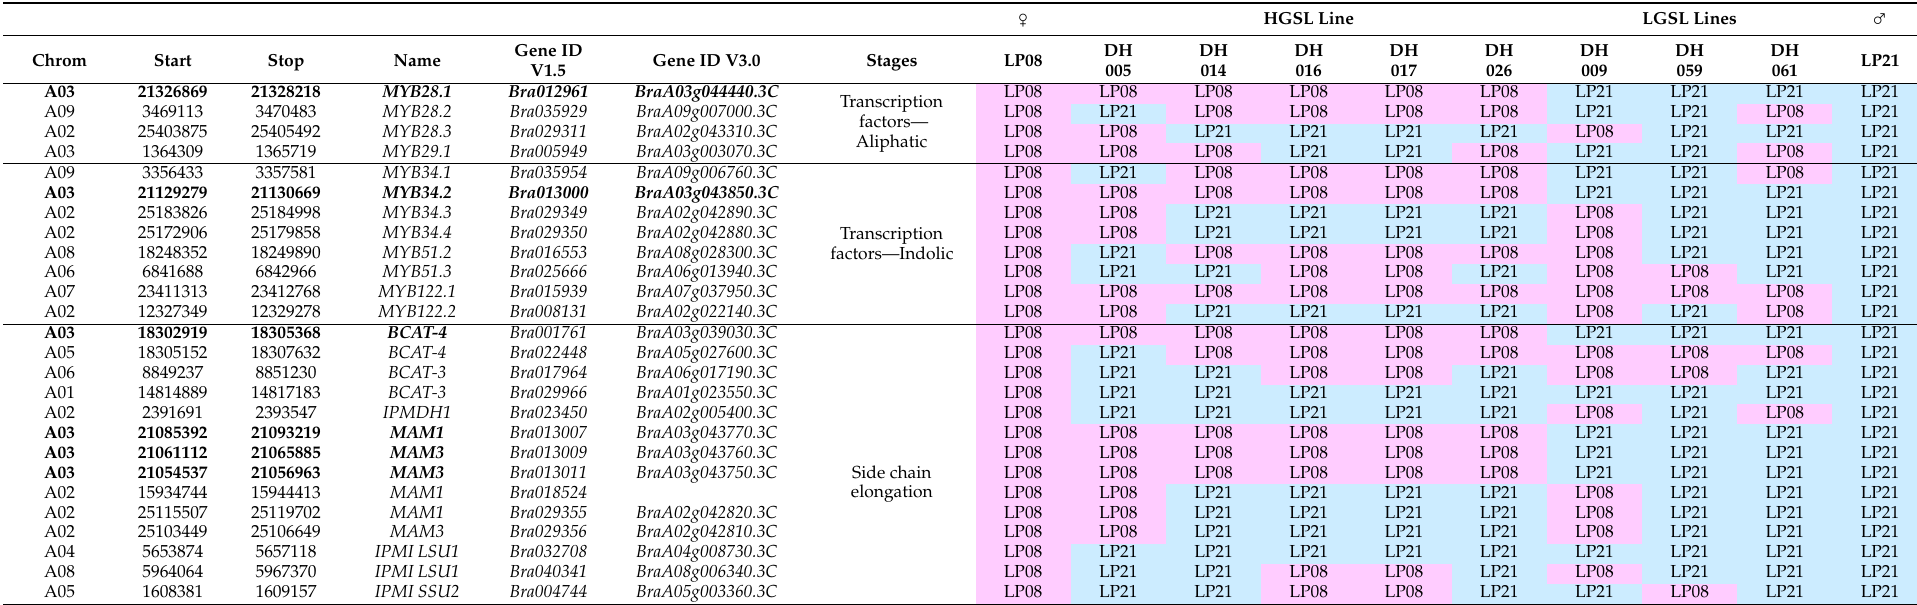
Table 3. Gene blocks identified as high (LP08) and low (LP21) GSL parents with the DH